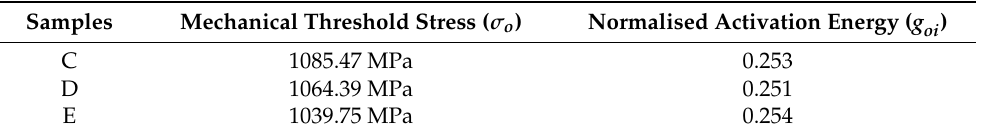
Table 2. Evaluated model-fitting parameters describing the thermal part of the yield stress of samples C, D, and E.